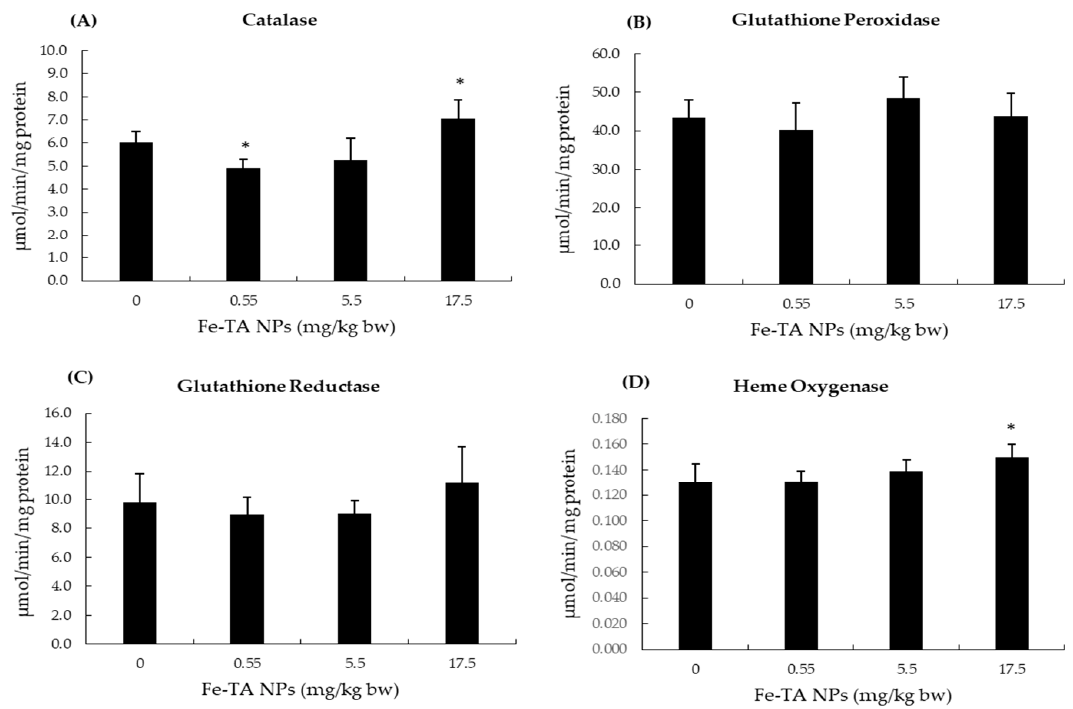
Figure 5. Effect of 10-week experiment of Fe-TA NPs on the activities of hepatic antioxidant enzymes in rats. ( A ): Catalase, ( B ): Glutathione peroxidase, ( C ): Glutathione reductase, and ( D ): Heme oxygenase. Data are expressed as Mean ± SD. * p < 0.05, significantly different when compared with a control